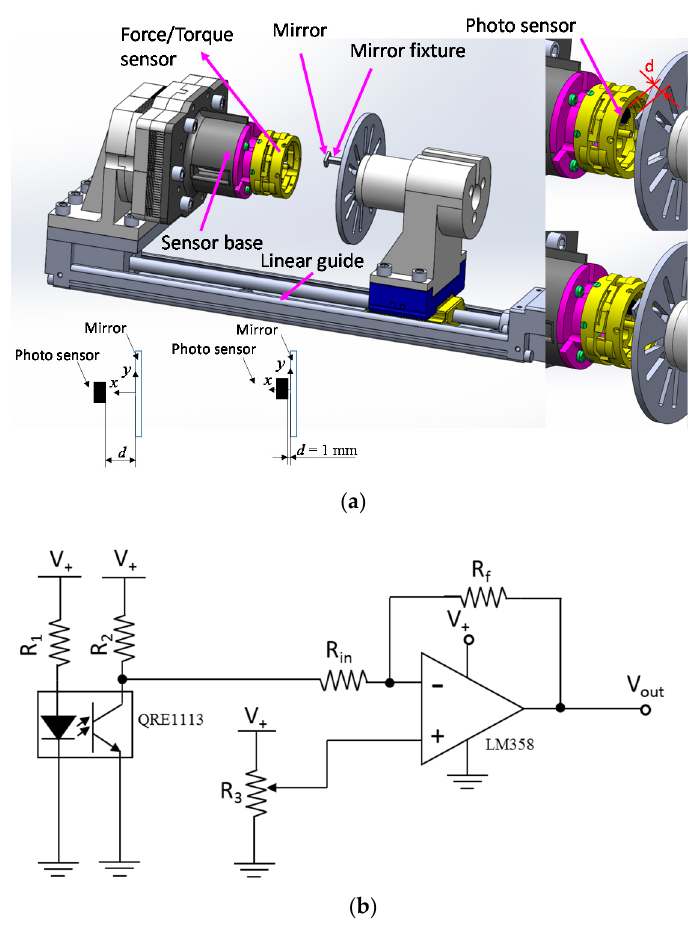
Figure 7. ( a ) Experimental setup to find optimized distance between an optoelectronic sensor and a mirror; ( b ) The inverting amplifier circuit with an optical sensor (R 1 = 100 Ω , R 2 = 5 k Ω , R 3 = variable resistor for offset, R in = 100 Ω , and R f = 9 k Ω ).